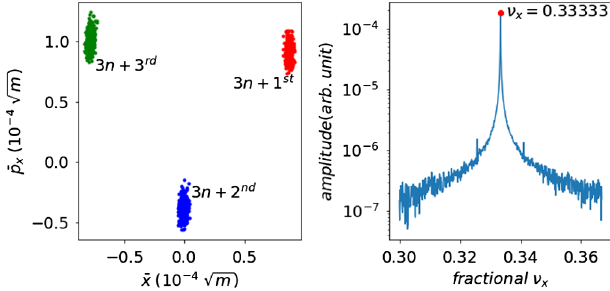
12. Left: measured beam turn-by-turn trajectories in the phase space with two neighboring beam position monitors (BPM). Three isolated islands are observed with a phase advance of 2 π in-between as expected. Right: the FFT spectrum confirms 3 that the beam remains stable on the third order resonance.